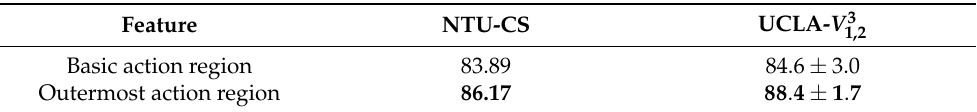
Table 3. Experimental results according to action region feature on the NTU-CS and UCLA- V 3 evaluation protocols. We use TAHNet-v1 and TAHNet-v2 as the temporal action head network on NTU-CS and UCLA- V 3 , 1,2